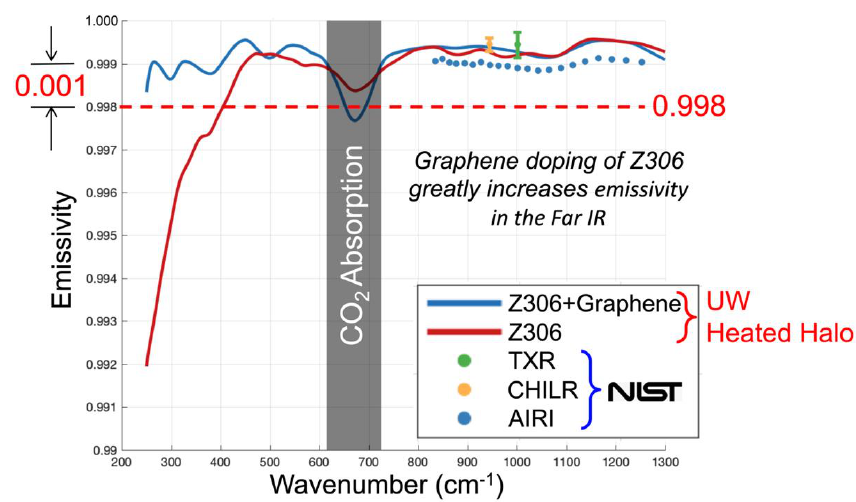
Figure 23. Laboratory emissivity measurements of the OARS cavity using the Heated Halo (red and blue solid curves), showing good agreement with three different independent NIST measurements.